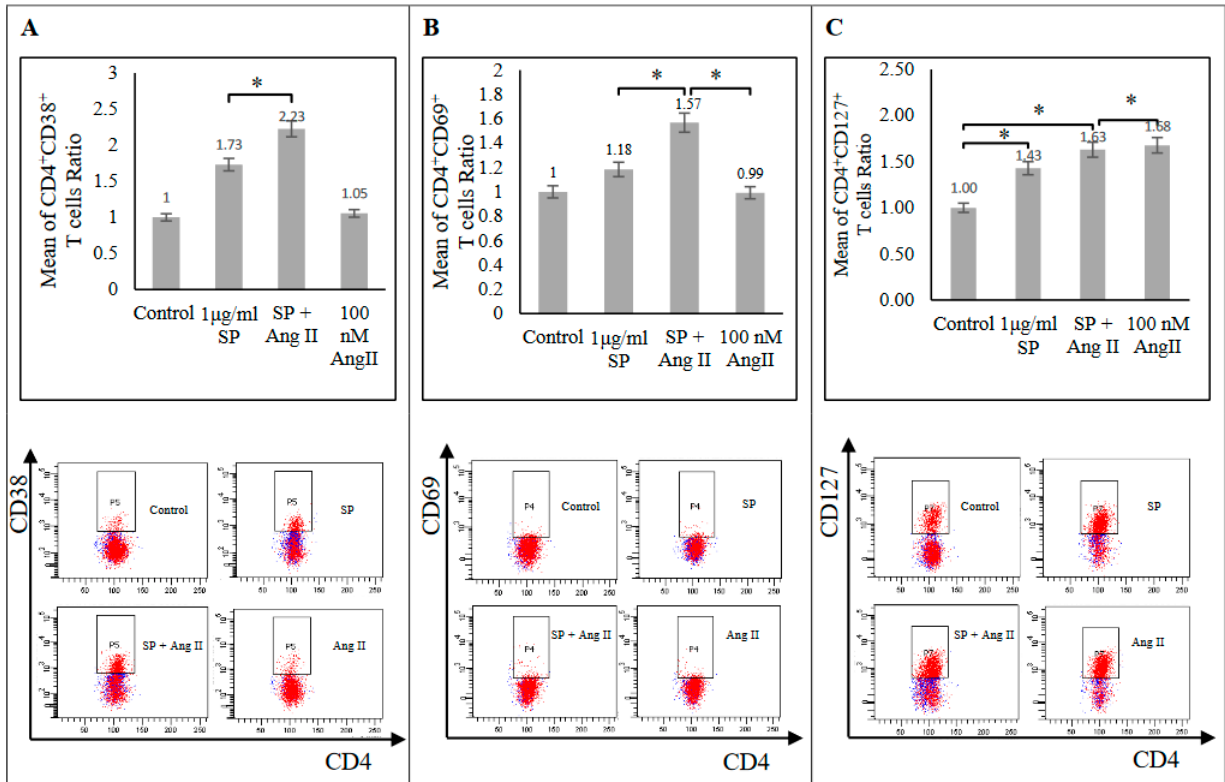
Figure 3. Activated CD4+ T-cells surface markers of recovered COVID-19 patients. ( A ) Upper: CD4+ CD38+ T-cells (n = 6). Lower: FACS representative plot. ( B ) Upper: CD4+ CD69+ T-cells (n = 7). Lower: FACS representative plot. ( C ) Upper: CD4+ CD127+ T-cells (n = 8). Lower: FACS representative plot. The ratio of CD4+ T-cells responses was measured as the mean of the percentage of the cell surface marker-positive T-cells in each group to the percentage of the cell surface marker-positive T-cells in the control group after the stimulation of PBMCs with a SARS-CoV-2 peptide pool (SP), angiotensin II (Ang II), or both of a SP and Ang II. *, p < 0.05.